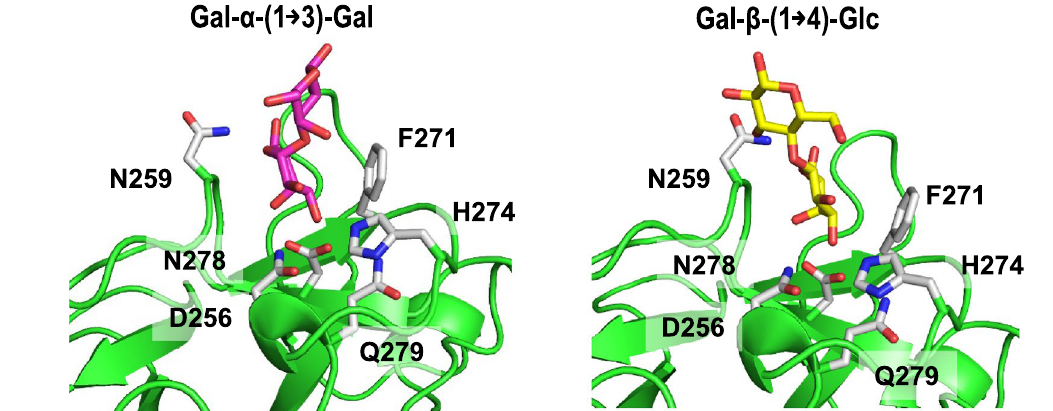
complexed with Gal-α-1,3-Gal (PDB, 5JM1) or replaced with Gal-β-1,4-Glc taken from the structure of BEL β-trefoil in complex with lactose (PDB 4I4S). Crystal structure analysis suggests that the α-Gal conformation is preferred because of the orientation of the β-linked chain which causes a direct clash with the N259 residue. The kink in the sugar chain brought about by the β- linkage hinders effective binding to the lectin. In contrast, α-linked Gal-α-1,3-Gal showed an ease of entry to the binding subsite (Fig. 3B, Supplementary Fig. S5). Next, we took results from Rn analysis and compared binding to sialylated glycans. Rn preferably binds to α-Neu5Ac than α-Neu5Gc residues (Fig. 4A, solid-line arrows). Looking at the models of HA1 WT in complex with Neu5Ac and Neu5Gc, the OH group of Neu5Gc makes the binding unfavorable because of steric consid- erations (Fig. 4B). These models were constructed by modifying the Neu5Ac ligands of a previously reported structure of HA1 complex with β-Neu5Ac (PDB ID, 3AHI). Furthermore, Rn binds to α-(2 → 3) Neu5Ac stronger compared to α-(2 → 6/8) Neu5Ac terminal ligands (Fig. 4A, dashed-line arrows). This could be explained by the structures of HA1 WT in complex with 3 sialyllactose (3’SL) and 6 sialyllactose (6’SL). Ligands (3SiaLac, PDB ID, 4EN6; 6SiaLac, PDB ID, 4EN8) were superimposed to the structure of HA1 WT based on the position of sialic acid and the HA1-Neu5Ac structure (PDB ID, 3AHI). Analysis of crystal structures show a possible